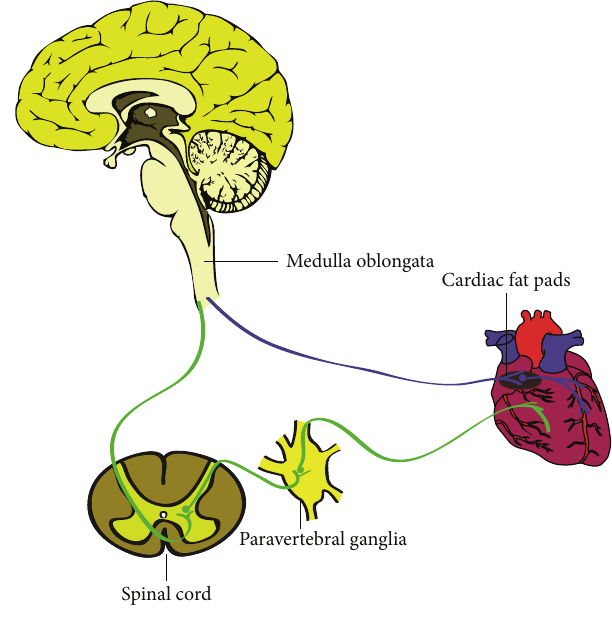
Figure1:Anatomyanddistributionofautonomicinnervationofthe heart. The cardiac parasympathetic nerves come from parasympa- thetic neurons located in the cardiac fat pads whose preganglionic fibers are carried within the vagus nerve. The cardiac sympathetic nerves come from the paravertebral ganglia and project from the base of the heart into the